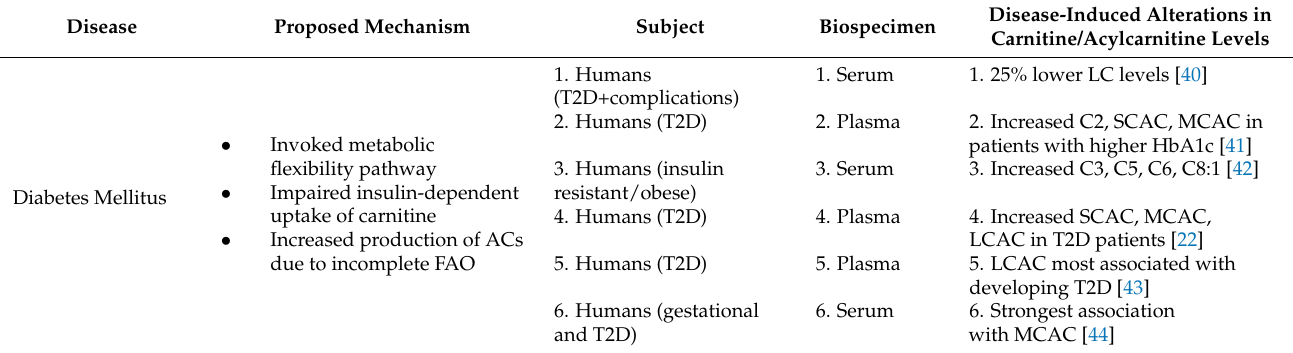
Table 1. Examples of diseases that influence blood levels of carnitine and acylcarnitines.